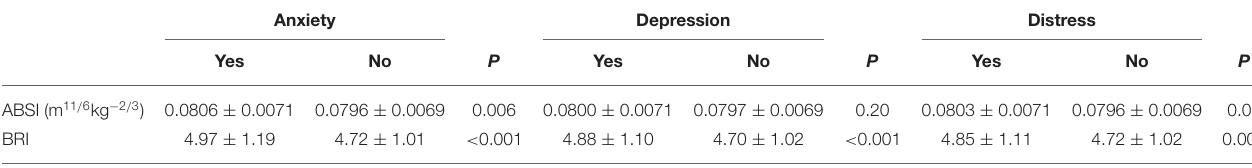
TABLE 3 | ABSI and BRI values of the study participants, based on their psychological health status a . Anxiety Depression Distress Yes No P